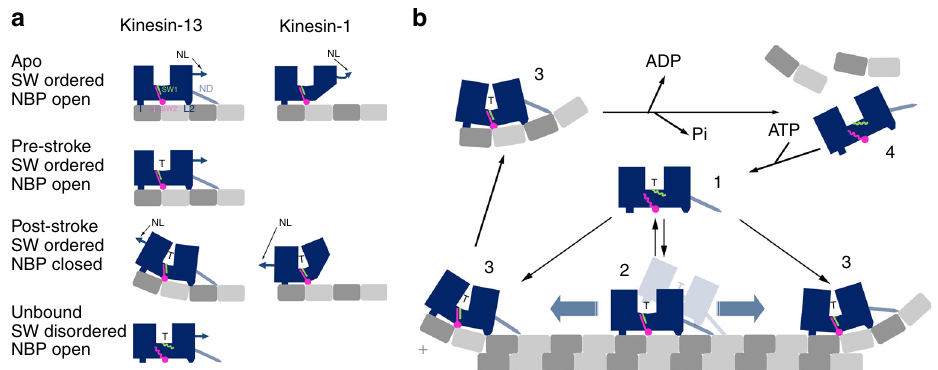
Fig. 7 Kinesin-13 microtubule depolymerization model. a Cartoon representing four distinct kinesin-13 conformations and equivalent states in kinesin-1: apo as in the NMMT apo complex; pre-stroke as in the NMMT AMP-PNP complex; post-stroke as in the CTMMT AMP-PNP complex; unbound as in the structures of several kinesin-13 motor domains not bound to tubulin. The switch regions are represented as green and magenta lines with straight or wavy lines indicating ordered or disordered conformations respectively. The three areas of interaction with tubulin are represented as a square (area I), a circle (area II, H4, SW2), and a trapezoid (area III, L2). The neck-domain is represented as a light blue line. Closing of the nucleotide pocket and reshaping of the tubulin interface is represented as a bending motion between the two halves of the motor domain (blue). SW switch regions, NBP nucleotide binding pocket, ND Neck-domain, NL Neck-linker, T: ATP. b Proposed model for kinesin-13 microtubule depolymerization and ATPase activity coupling (neck-linker on the KLP10A motor domain cartoon representation not shown). See main text for